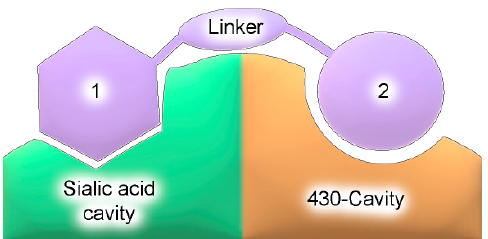
Figure 2. Schematic representation of a hypothetical bifunctional neuraminidase inhibitor. Structural fragments 1 and 2 connected by a linker are bound to different sites on the protein surface.